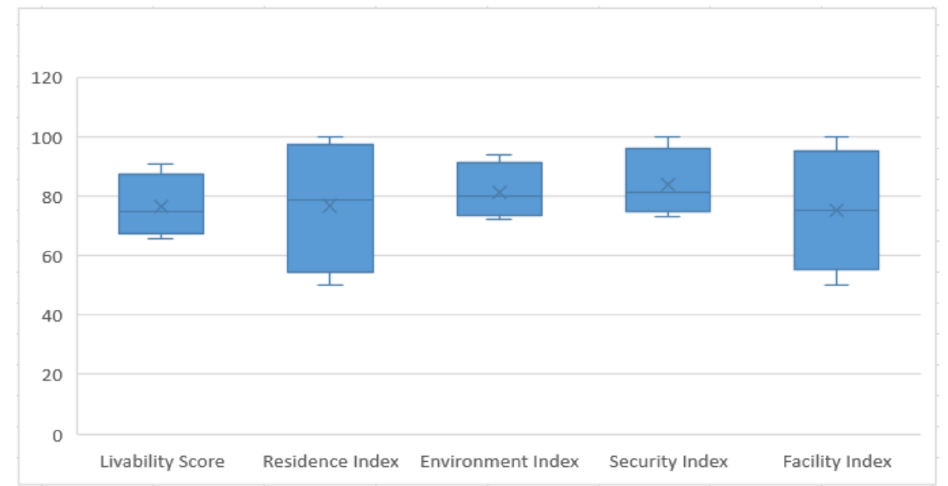
Figure 8. Overall and dimension scores of community livability: The overall scores range from 70 to 90 and the dimensions scores range from